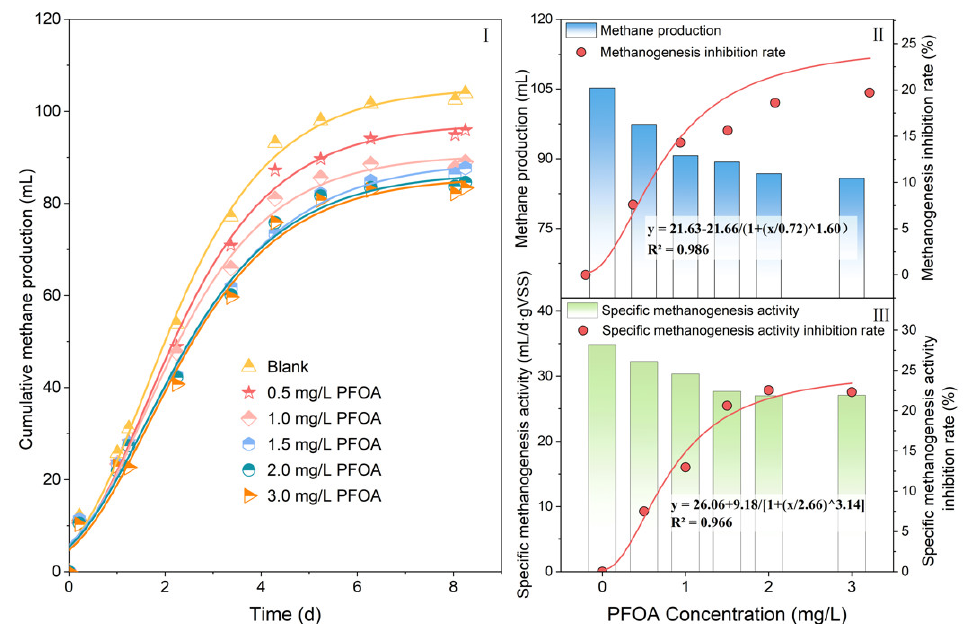
Figure 1. Cumulative methane production of AD under different levels of PFOA stress ( I ), fitting curve of energy recovery from inhibited AD under different concentrations of PFOA ( II ), and fitting curve of sludge activity variation under PFOA stress ( III ) .